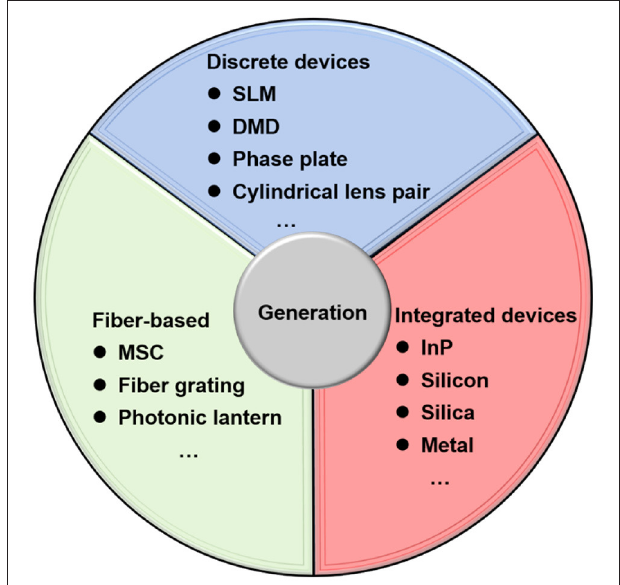
FIGURE 2 | Methods and devices for generation of spatial-structured light beams. SLM, spatial light modulator; DMD, digital micro-mirror device; MSC, mode selective